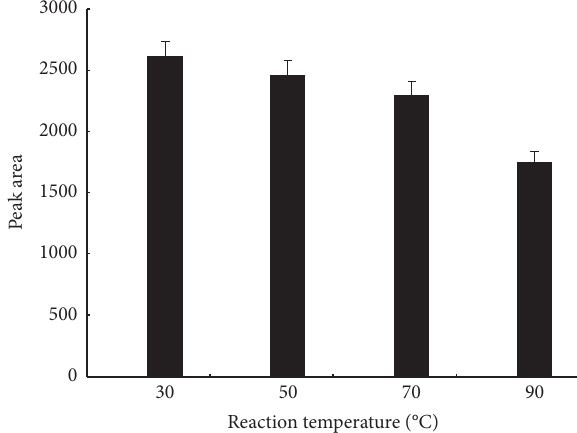
Figure 2: Effect of reaction temperature on luteolin-metal complex formation. Luteolin (0.1mmol) was mixed with 0.02mmol anhy- drous calcium chloride, anhydrous zinc chloride, magnesium chloride hexahydrate, iron chloride hexahydrate, or copper chlo- ride dihydrate in 40mL distilled water. The reaction was allowed to proceed for 4h under heat backflow at a temperature of 30 ° C, 50 ° C, 70 ° C, or 90 ° C. After free ion salts were removed, the reactants were analyzed by HPLC as described in methods. The experiment was performed at least three times